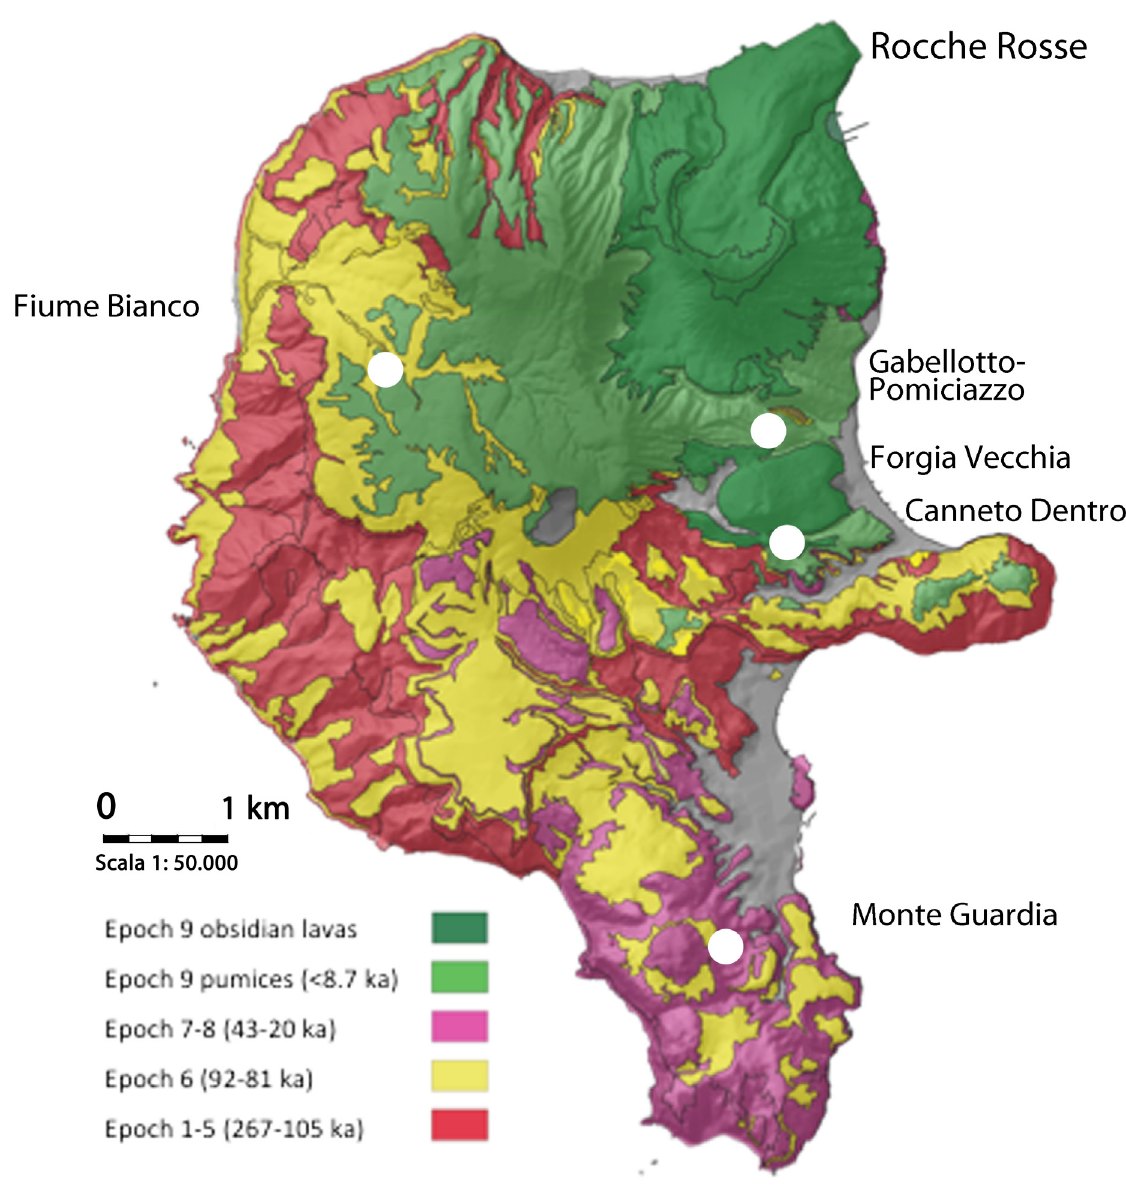
Figure 3: Geological sketch map of Lipari island (modified after Forni et al., 2013); sampling sites of geological samples, white dots on the